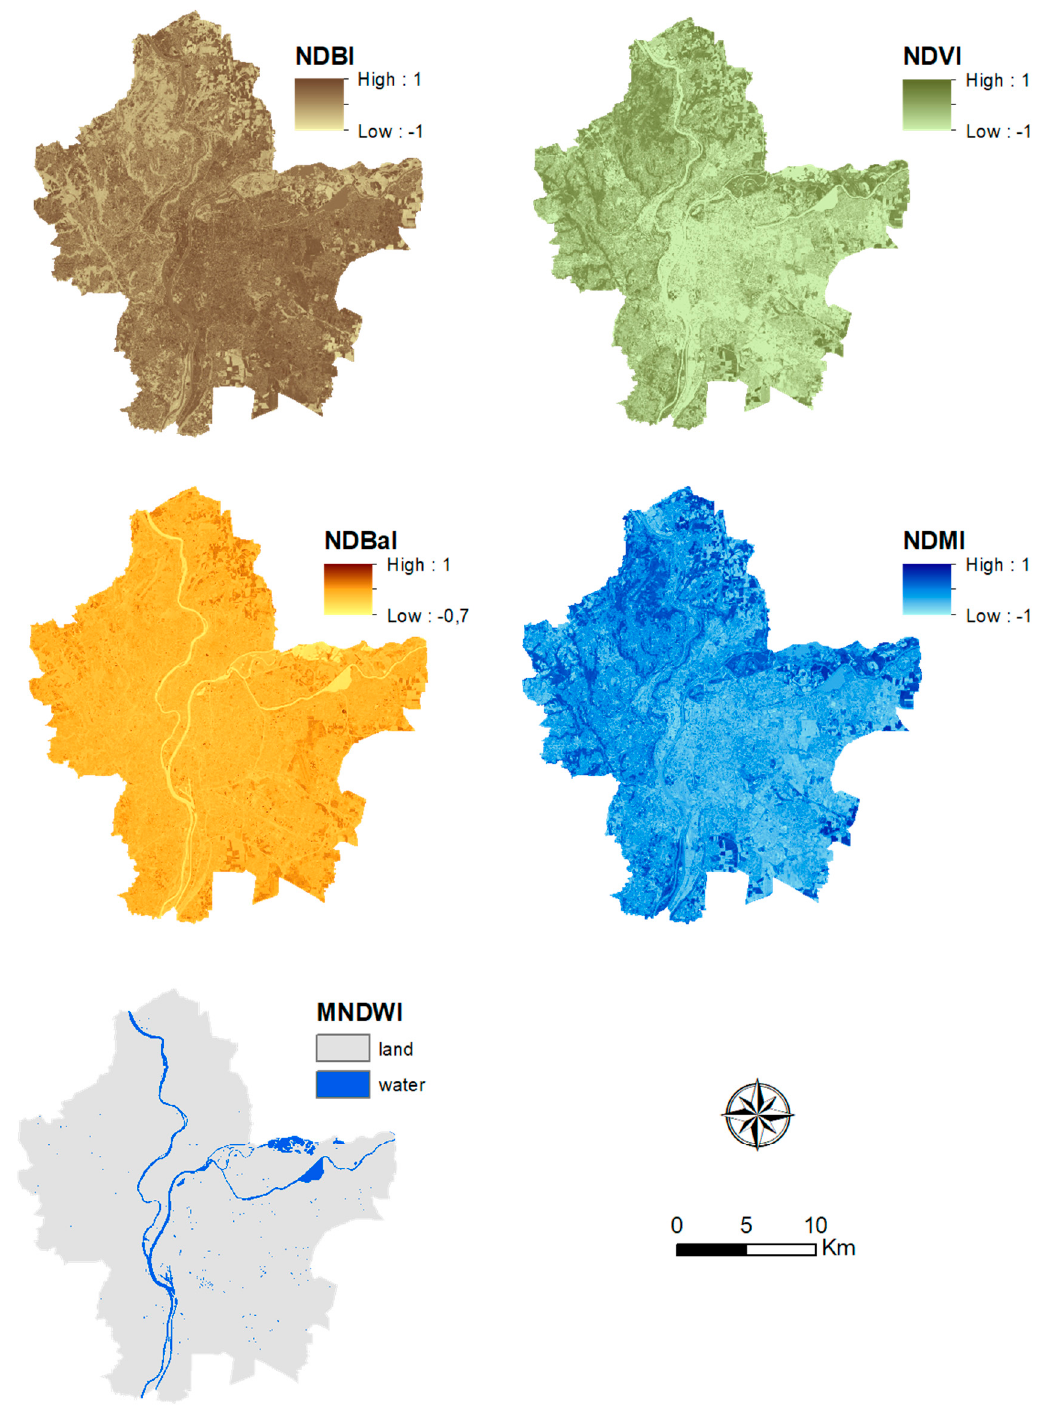
Figure 6. NDBI, NDVI, NDBaI, and NDMI on 16 July 2017 in the Lyon urban area.